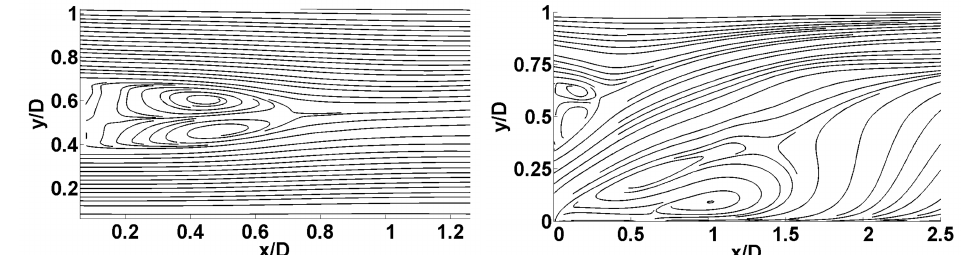
Figure 5. Recirculation zones in the vertical symmetry plane in the kiln, with PIV results to the left (for geometry, see Figure 3b) and CFD results to the right (for geometry, see Figure 3e). Figure adapted from [39].